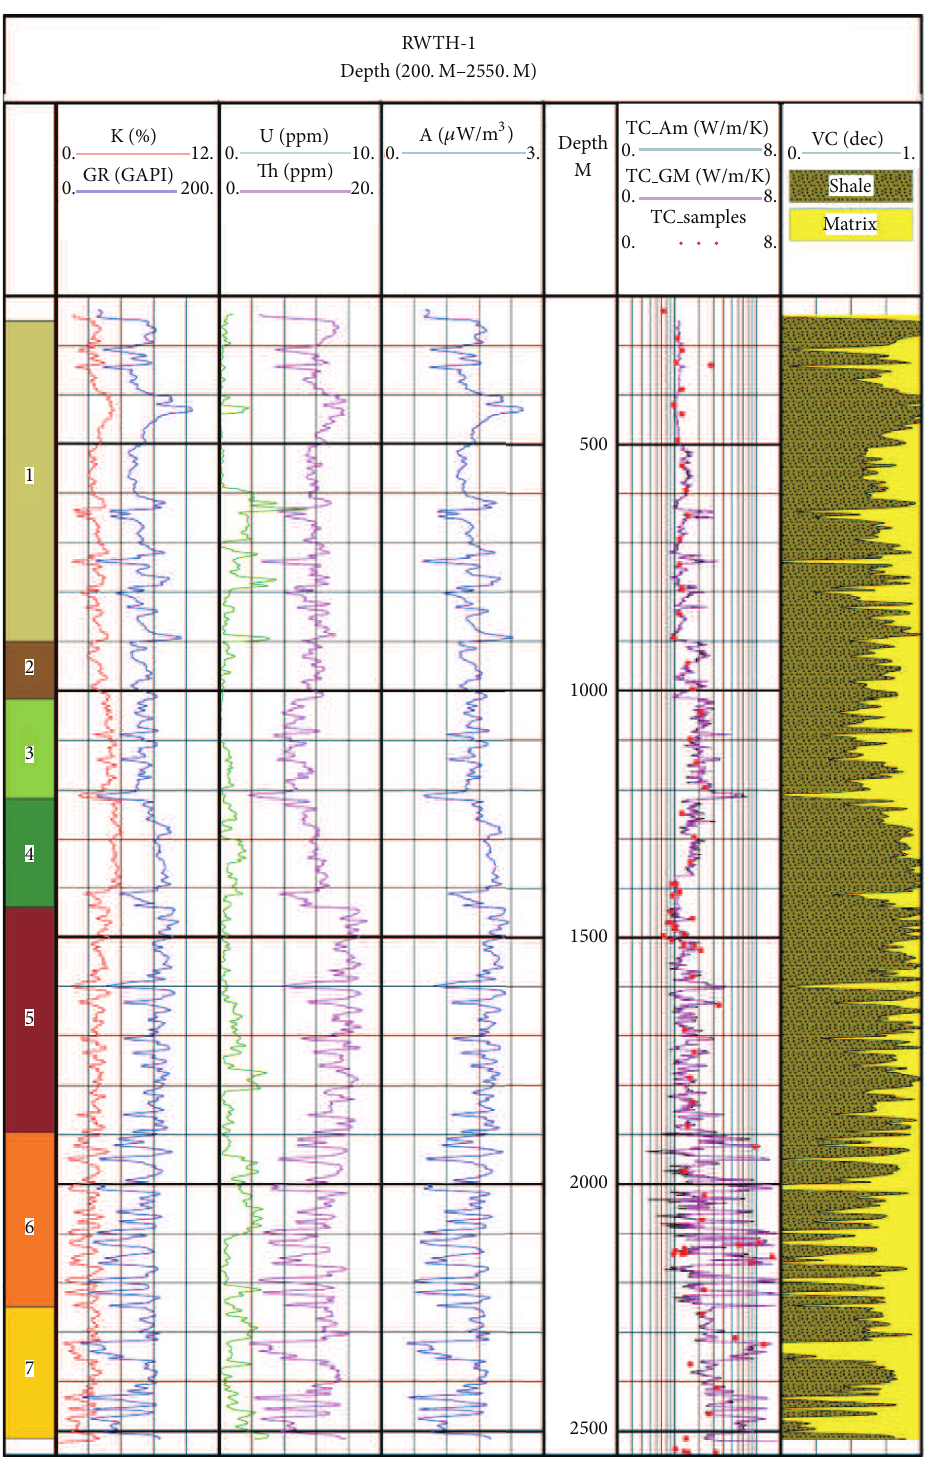
Figure 8: Thermal conductivity TC AM (arithmetic mean) and TC GM (Geometric mean) and heat generation A derived from volume fraction based on total (GR) and spectra (K, U, Th); colors indicate different zones of the